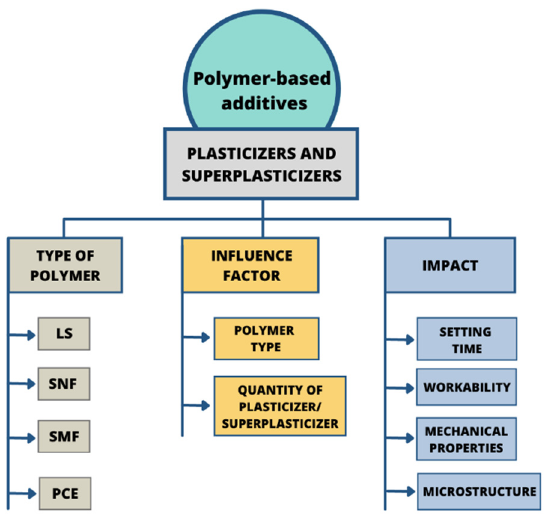
concrete-based Figure 2. Scheme of plasticizer and superplasticizer types, influence factors and changes caused in concrete-based composites.